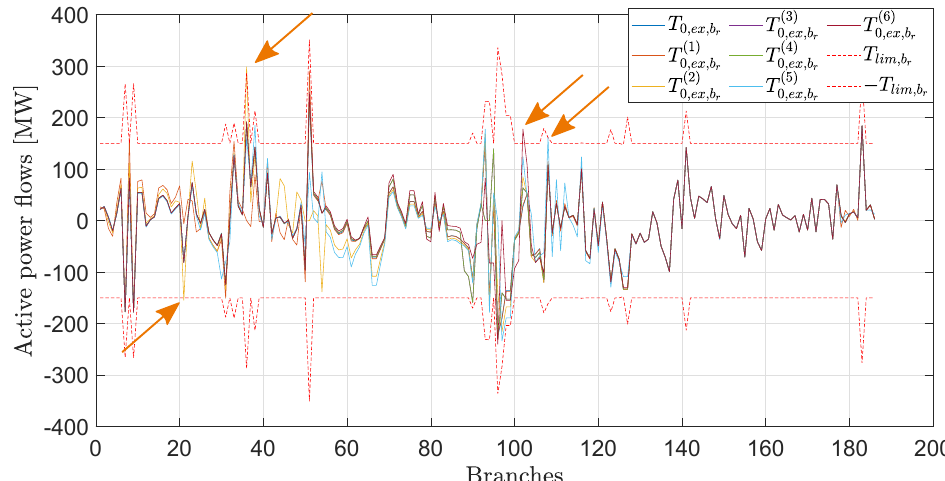
Figure 8. Active power flows after active power control − Scenario APC2.